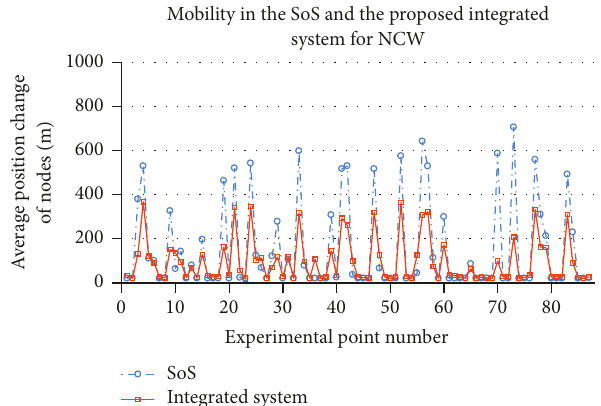
Figure 14: Mobility model results of the SoS and the proposed integrated system for